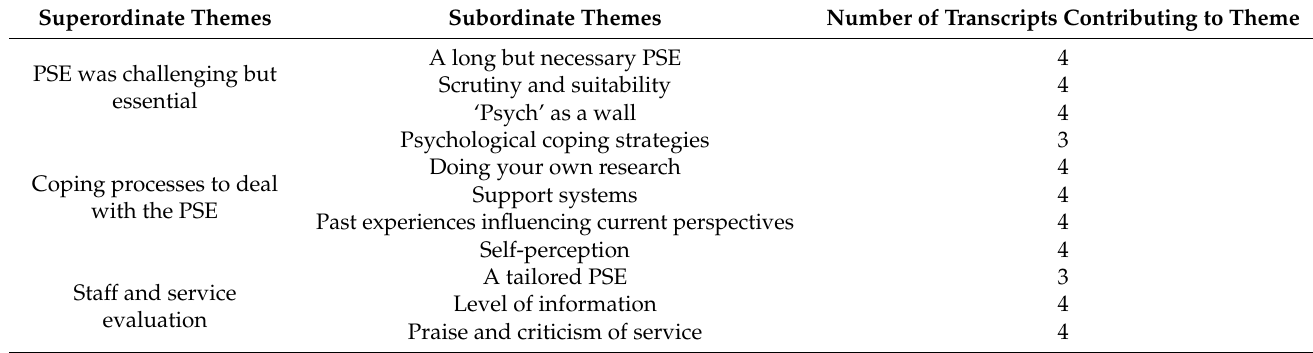
Table 2. Master Table of